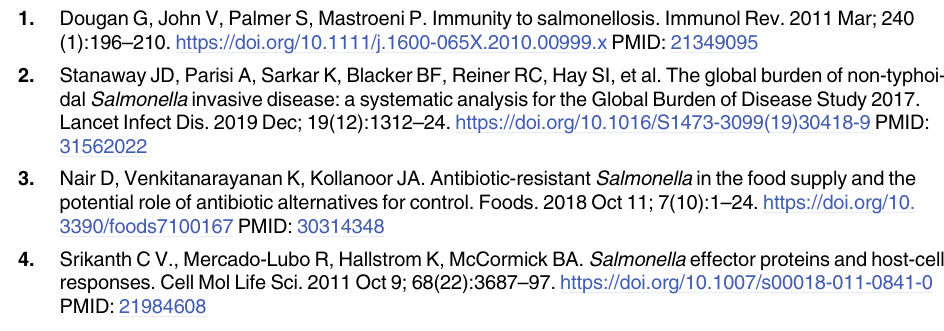
uninfected M2 macrophages are in green. Genes up or downregulated in M EP vs. M2 macro- phages are indicated with “u” and “d” respectively. Genes up or downregulated in M EP vs. M1 macrophages are indicated with “+” and “-” respectively. S6 Fig. Differentially expressed genes associated with chromatin modification or other epi- genetic regulation. The colour of the dots indicate the fold change gene expression: upregu- lated genes are red/orange, while downregulated genes are green. The size of the dots indicates the significance level of the pathway enrichment, -log (adjusted p-value), such that larger dots 10 have smaller p-values. “p-adj” refers to the p-value adjusted using the Benjamini-Hochberg correction for multiple testing. Only genes for which the adjusted p-value was � 0.05 and the fold change was > 2 or < -2 are